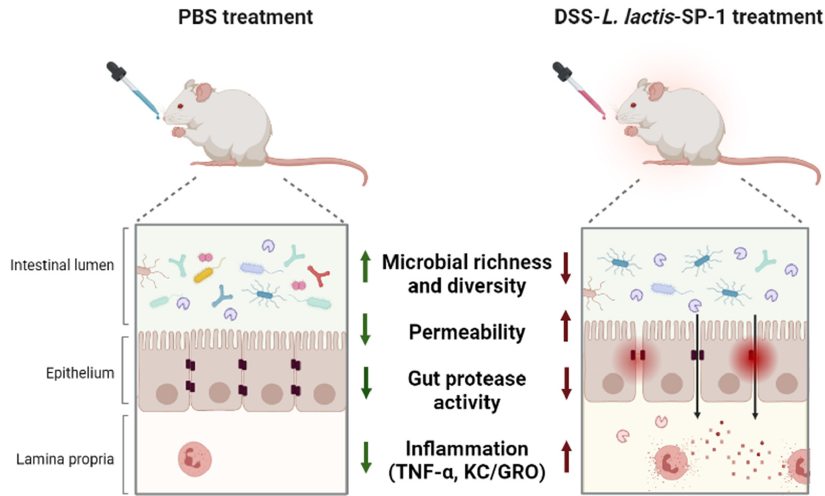
Figure 8. Graphic summary of the study design and main findings.